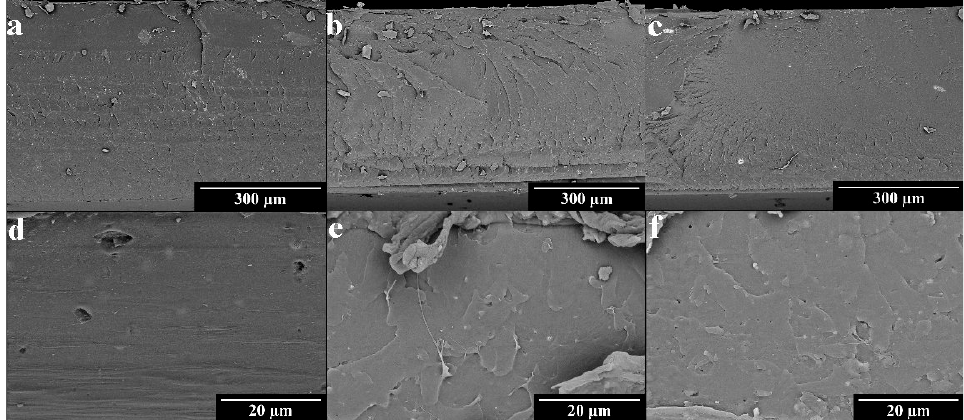
Figure 3. FSEM images of LDPE composites. ( a ) 0.1% CuHS; ( b ) 0.3% CuHS; ( c ) 0.5% CuHS and PLA composites; ( d ) 0.1% CuHS; ( e ) 0.3% CuHS; and ( f ) 0.5% CuHS.